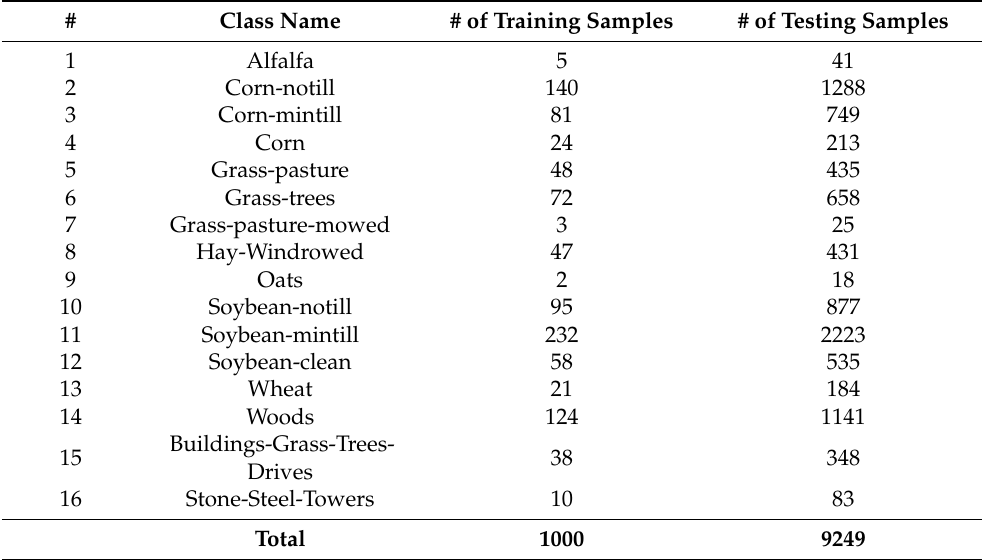
Table 2. Total number of class-specific training and testing samples used for Indian Pines dataset with 10% of training